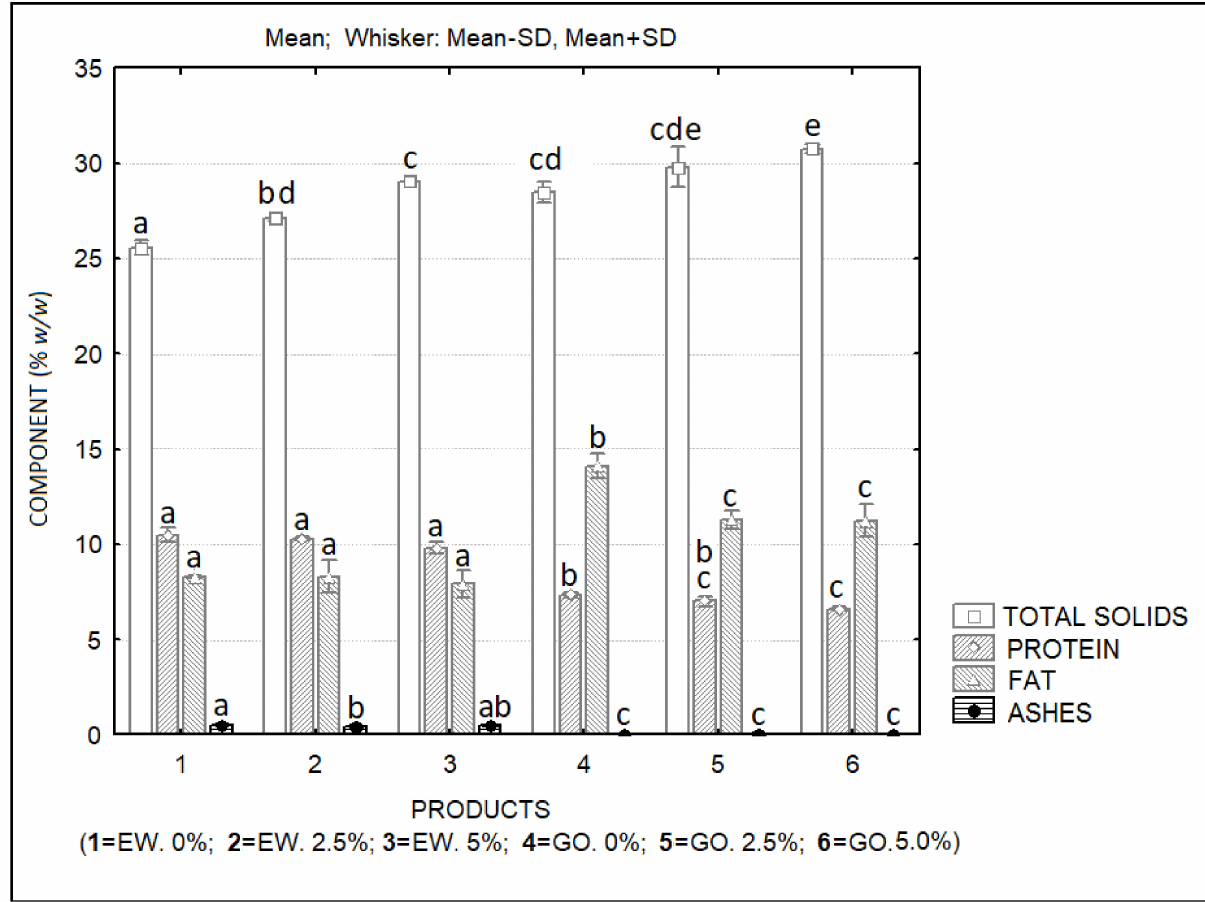
Figure 4. Gross chemical composition of ewe’s and goat’s frozen yoghurts produced with UF concentrated cheese whey over 21 days of refrigerated storage (EW. 0% = ewe’s yoghurt with 0% inulin addition; EW. 2.5% = ewe’s yoghurt with 2.5% inulin addition; EW. 5.0% = ewe’s yoghurt with 0% inulin addition; GO. 0% = goat’s yoghurt with 0% inulin addition; GO. 2.5% = goat’s yoghurt with 2.5% inulin addition; GO. 5% = goat’s yoghurt with 5% inulin addition). Different letters indicate significant differences ( p < 0.05) between components of ewe’s and goat’s frozen yoghurt